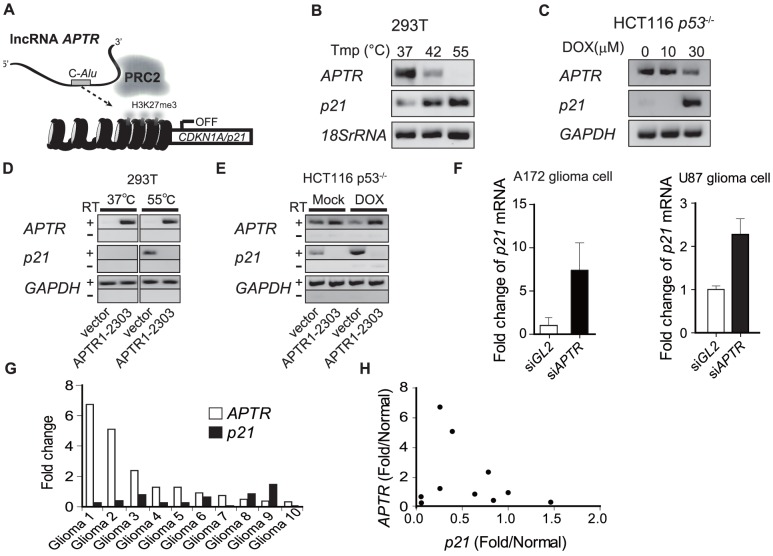
The implication of APTR-mediated p21 silencing in normal cell function and cancer.(A) A schematic of the lncRNA APTR-mediated p21 gene silencing. APTR suppresses p21 gene expression by guiding the PRC2 complex to the p21 promoter. (B–C) RT-PCR of indicated transcripts in indicated cells. GAPDH and 18SrRNA are loading controls. (D–E) Overexpression of exogenous APTR (indicated at bottom) suppresses the induction of p21 after heat shock or after Doxorubicin in indicated cells. RT: reverse transcriptase. Fewer PCR cycles were done compared to Figure 7B explaining why endogenous APTR is not seen. (F) siAPTR induces p21 in human glioma cells. Q-RT-PCR of p21 mRNA normalized to GAPDH. Mean ±s.e.m; n = 3. (G) Levels of APTR and p21 mRNAs in ten GBMs. Fold change in the GBM relative to normal brain tissue (average of two normal brains). (H) Scatter plot of the data in Figure 7G to show the anti-correlation between APTR and p21 RNAs. Pearson R = −0.254. unpaired t test P = 0.004, n = 10.